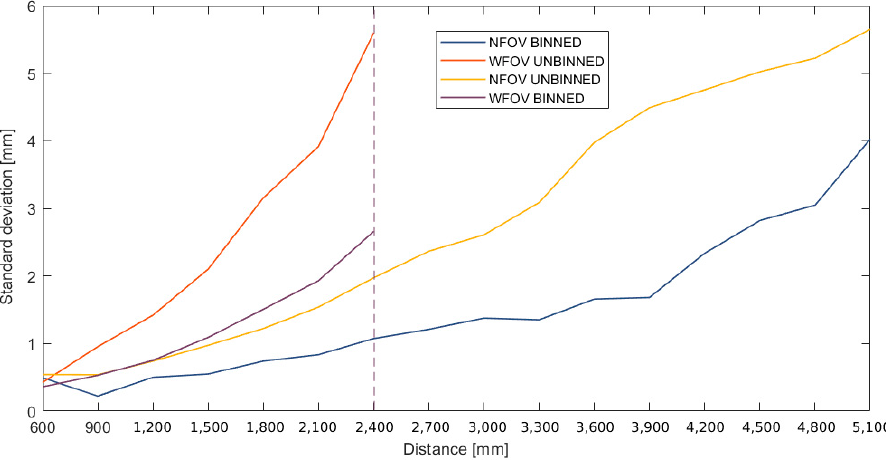
Figure 13. Evolution of standard deviations of measurements as a function of distance [in mm].